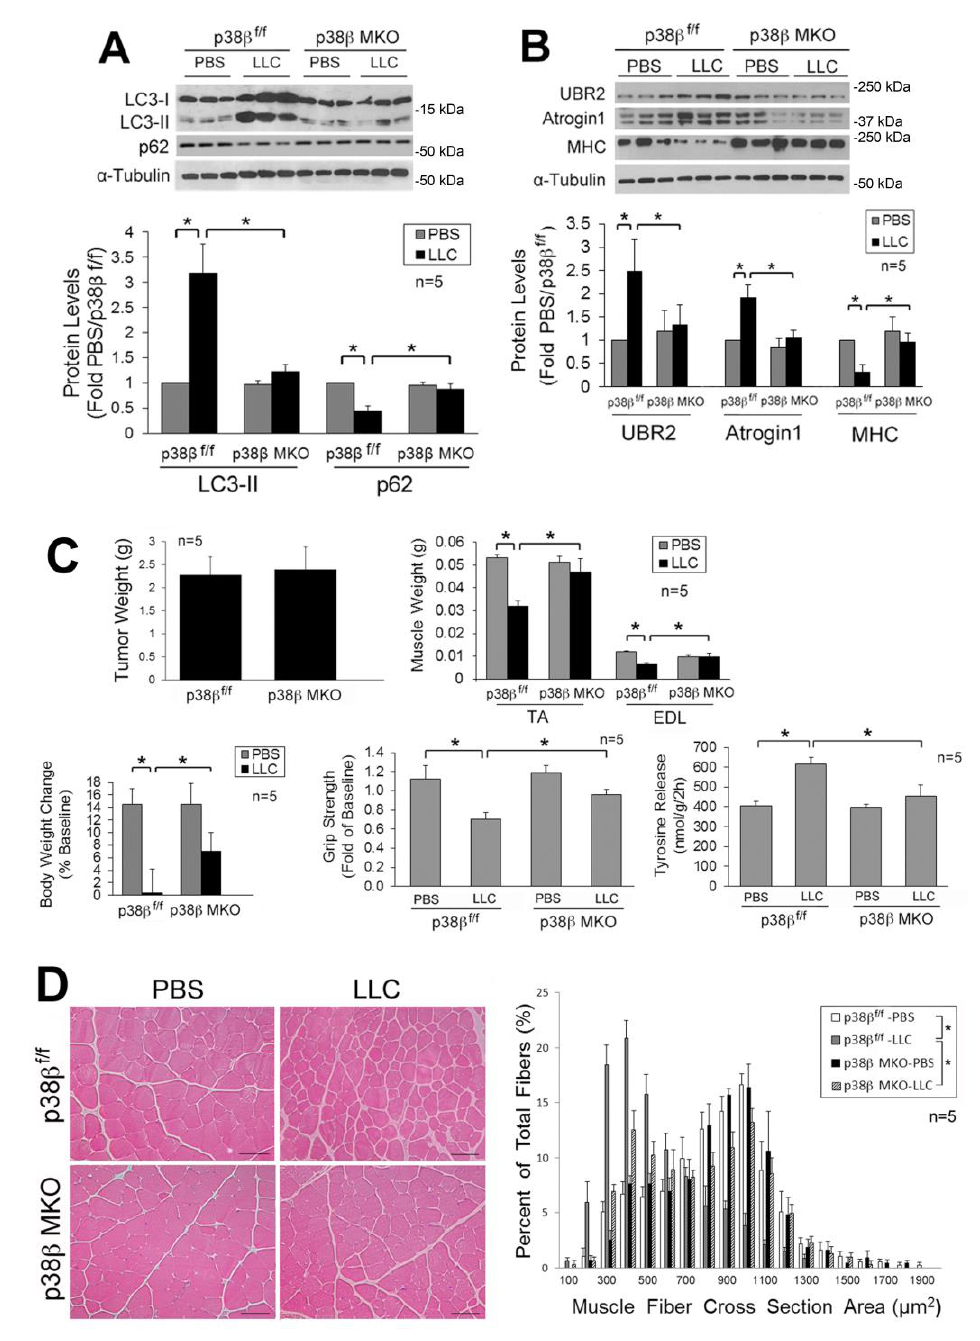
FIGURE 2: Muscle-specific knockout of p38  MAPK abrogates activation of autophagy, UPP and muscle wasting in tumor-bearing mice. Mice with muscle-specific knockout of p38  MAPK and control mice (p38  MAPK f/f ) were implanted with LLC cells. In 21 days, mice were euthanized for analysis of muscle wasting. Lysate of TA collected from the mice was analyzed by Western blotting for LC3 and p62 to evalu- ate autophagy activity (A) and UBR2, atrogin1 and MHC to evaluate UPP activity (B) . Muscle wasting in the mice was analyzed by examining tumor weight, body and muscle weight, tyrosine release and grip strength (C) . Muscle mass was measured as muscle fiber cross sectional area (D) . Data in A to C were analyzed by one way ANOVA. Data in D were analyzed by Chi-square analysis. * denotes a difference (p <